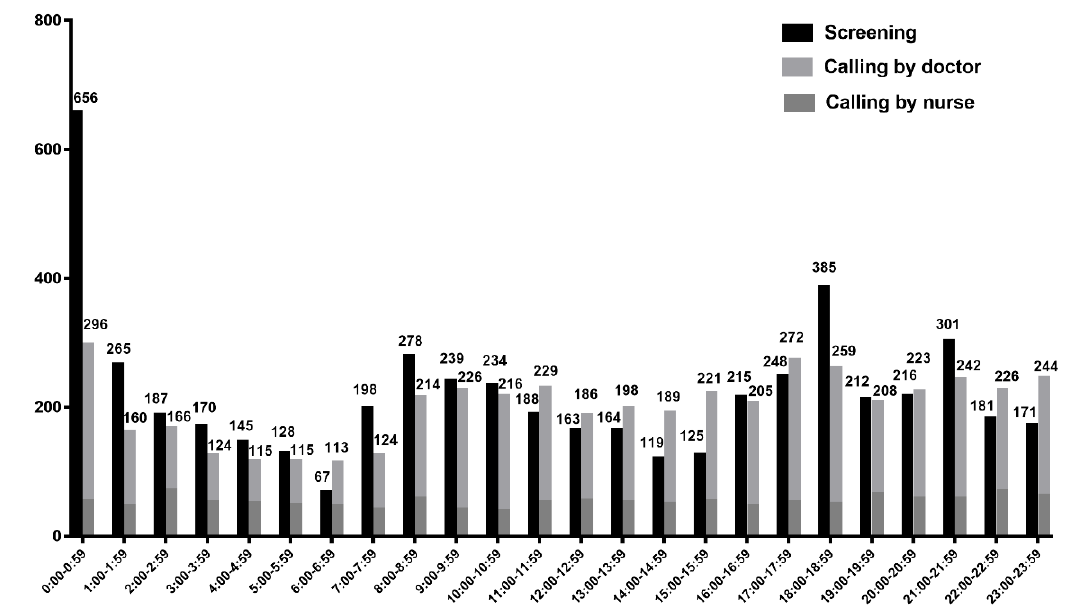
Figure 3. The RRT frequency according to each clock hour. Among 10,026 events, 4771 (47.6%) were triggered by calling and 5255 (52.4%) were triggered by screening. RRT contacts are most frequent at midnight to 00:59 am ( n = 952, 9.5%). The total frequency was higher in order of 18:00 pm, 21:00 pm, and 8:00 am. Data are presented as number of